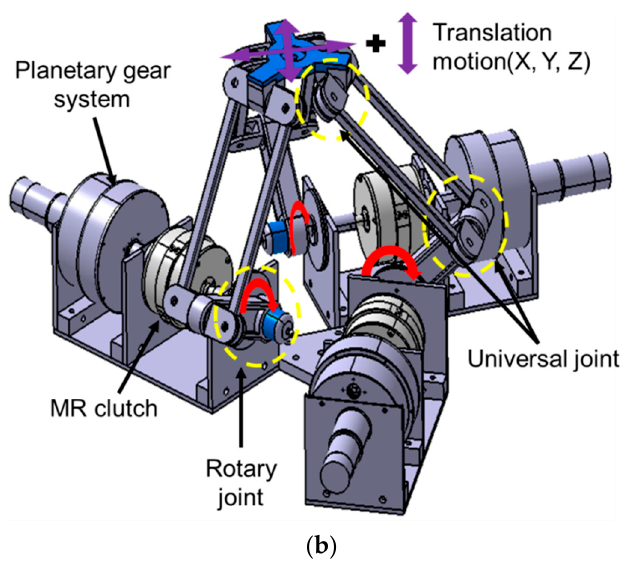
Figure 10. Overall configurations of the haptic master; ( a ) rotational part; ( b ) translational part.